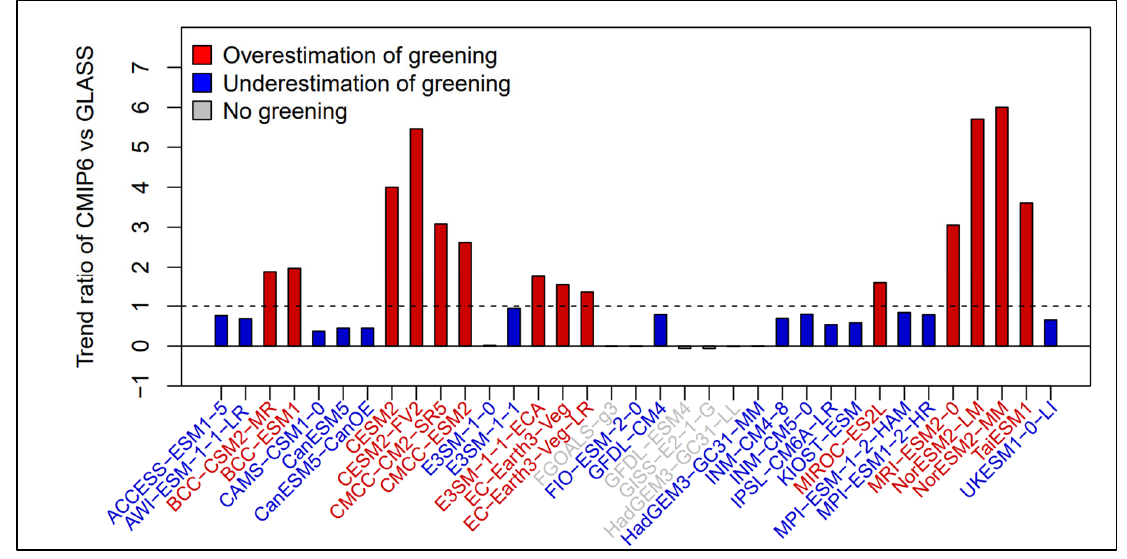
Figure 3. The ratio of the area-averaged LAI trend of the growing season (1981–2014) between each CMIP6 models and the GLASS data.